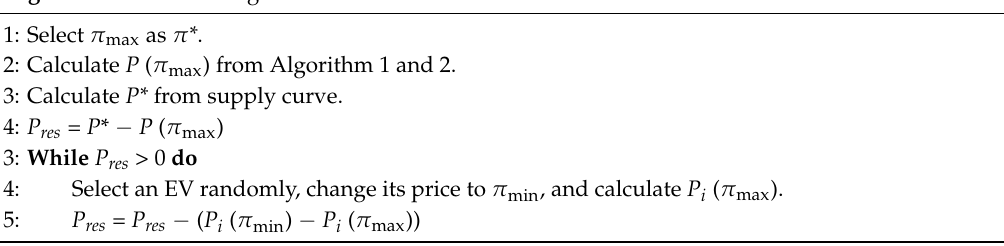
Algorithm 4. Second Stage—Part 2: Allocate of Residual Power